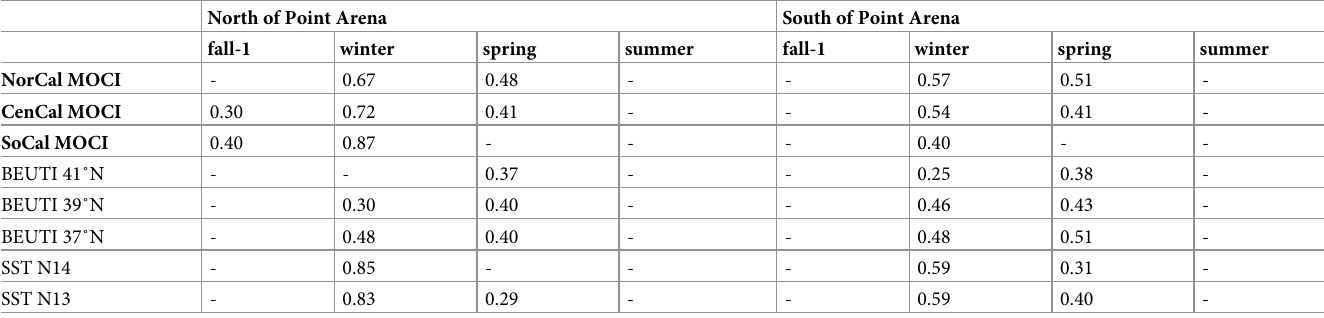
Table 1. R 2 values for linear regressions of kelp canopy cover.